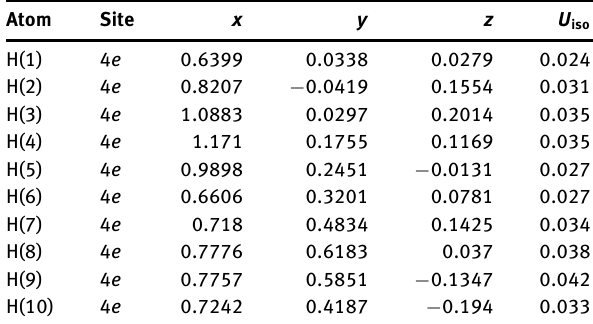
Table 2: Atomic coordinates and displacement parameters (Å 2 ).